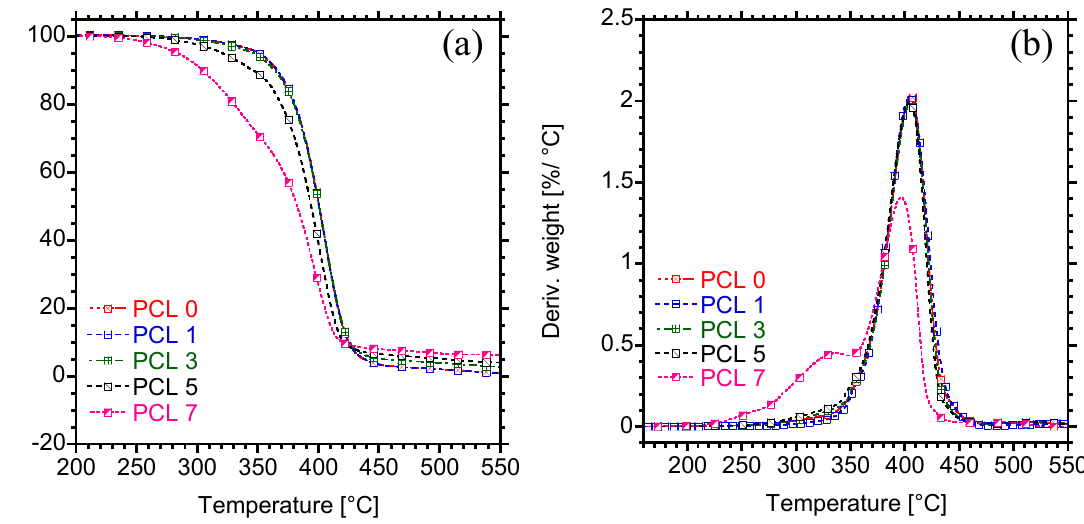
Figure 8. ( a ) Thermal degradation curves and ( b ) Derivative curves of PCL and PCL/HAP composites. Table 3. Summarized onset and maximum degradation temperatures of PCL and PCL/HAP composites.